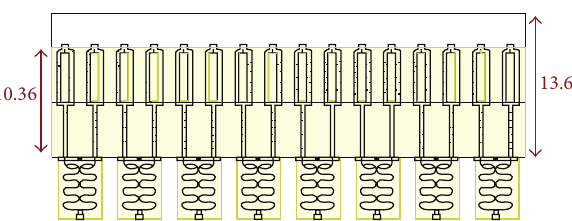
Figure 7: Detail of the 8 PCB boards balun feeds with the Winkinson divider below the ground plane. All dimensions are in cm.